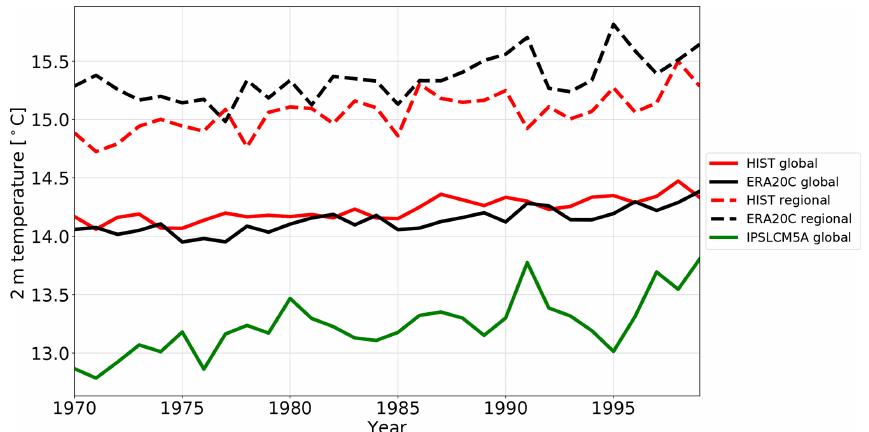
Figure 2. Time series of annual mean surface air temperatures at 2m in HIST (red) and ERA20C (black; Stickler et al., 2014) and IPSL- CM5A (green) for the global average (solid lines) and Mediterranean region (20–50 ◦ N, 10 ◦ W–35 ◦ E) average (dashed lines).